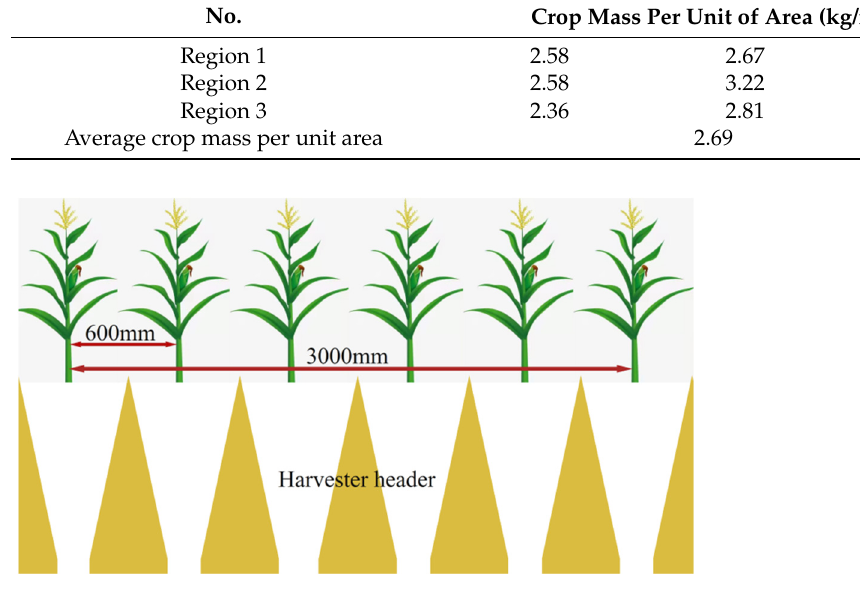
Figure 4. Harvester header field operation status